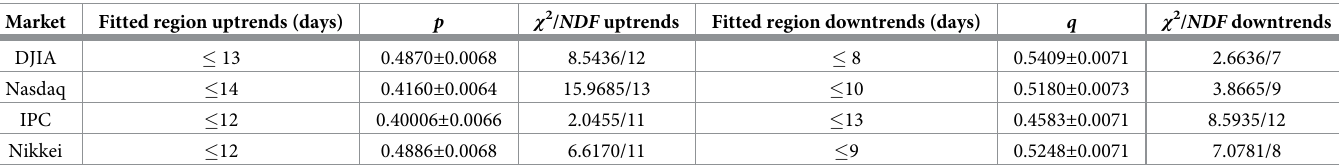
Table 7. Fitted p and q parameters of the geometric model. DJIA and Nikkei empirical trend durations distribution are well fitted by the geometric model. Nasdaq and IPC are not. NDF means “number of degrees of freedom”. Fits were performed on the data listed in Tables 2–5. Market